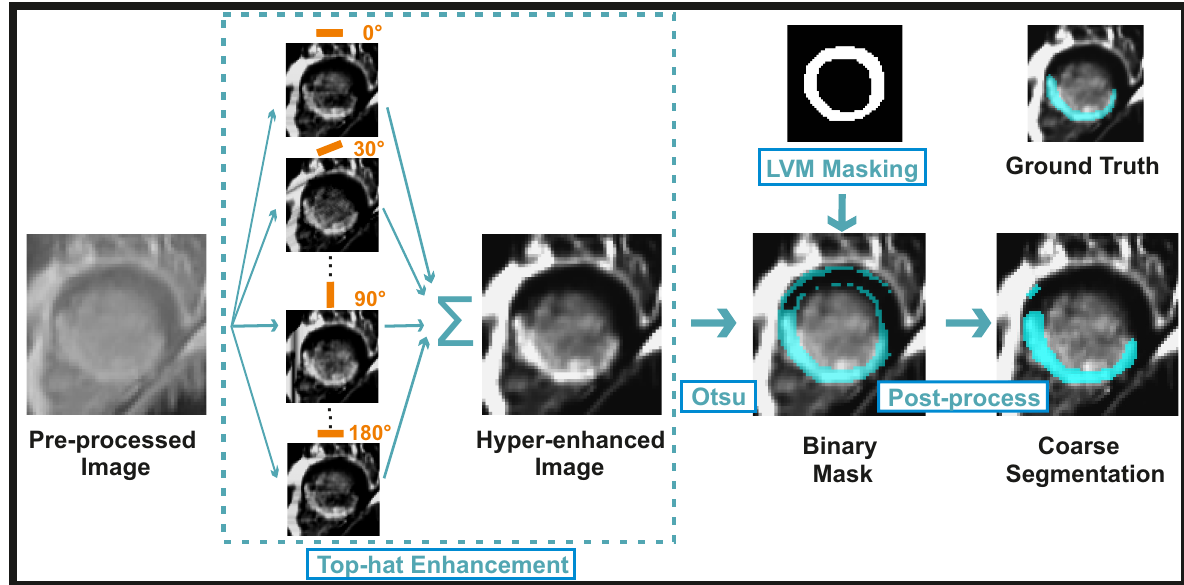
Figure 1. Coarse segmentation